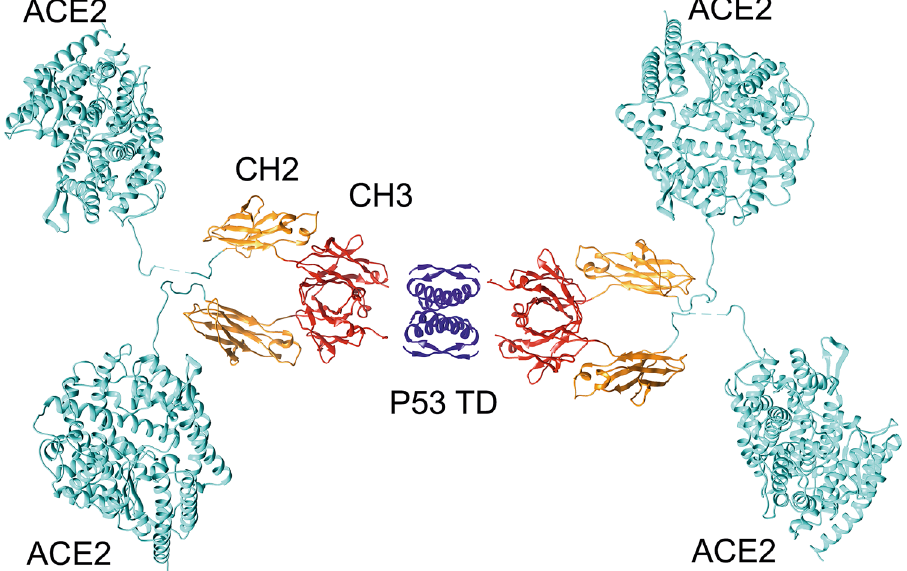
Figure 2. Molecular model of the ACE2-Fc-TD Quad protein. A model of the putative structure of the ACE2-Fc-TD Quad protein, assuming the P53 tetramerisation domain is the major driver of oligomerisation. SEC-SAXS, SEC–MALLS and AUC data support an elongated and tetrameric structure for this protein. The colour scheme comprises the ACE2 extracellular domain coloured in cyan, the IgG CH2 domain in orange and the IgG CH3 domain in red, with the tetramerization domain of P53 (P53 TD) coloured blue. A gap has been left between P53 TD and CH3 domain of each IgG to account for the flexible 6 amino acid linkers between these